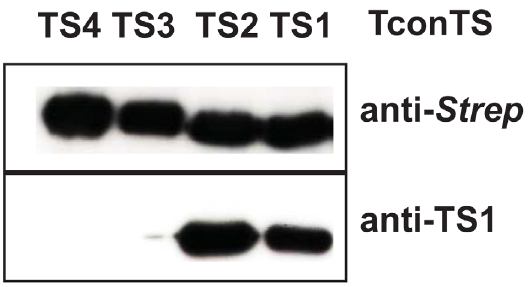
Figure 3. Recognition of TconTS proteins by antibodies. 100 ng of affinity purified TconTS proteins were analysed by Western blot as described under Methods. Blots were probed either with polyclonal rabbit anti-Strep (upper pane) or with monoclonal mouse anti-TS1 antibody, which shows cross reactivity with TconTS2 (lower pane).